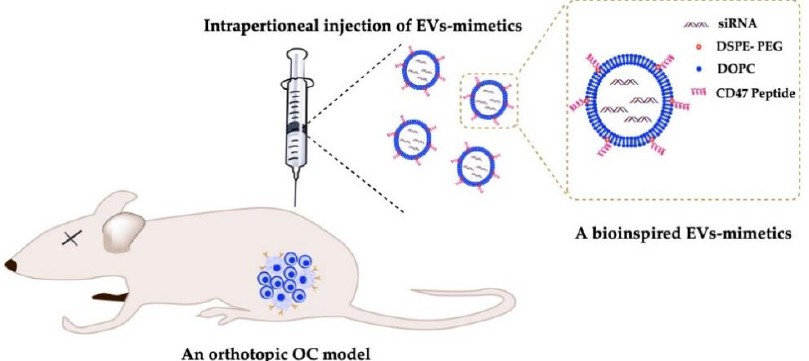
Figure 4. Delivery of EV-mimetics with RNAi cargo to mouse OC models. The CD47 peptides will help improve the pharmacokinetics by preventing macrophage-mediated phagocytosis, while the encapsulated siRNA induces gene silencing in ovarian tumors.